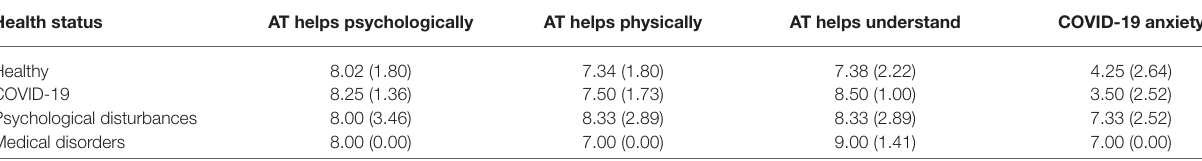
TABLE 2 | Health status, evaluation of AT benefits (psychological, physical, and relational) and COVID-19-related anxiety.